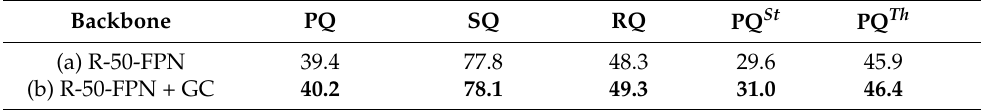
Table 5. Panoptic segmentation results on the COCO val2017 dataset. Here ResNet is abbreviated as ”R”. Incorporating global contexts (GC) improves the quality of panoptic segmentation in all metrics. The number in bold means superiority compared to that of the baseline in the metric.